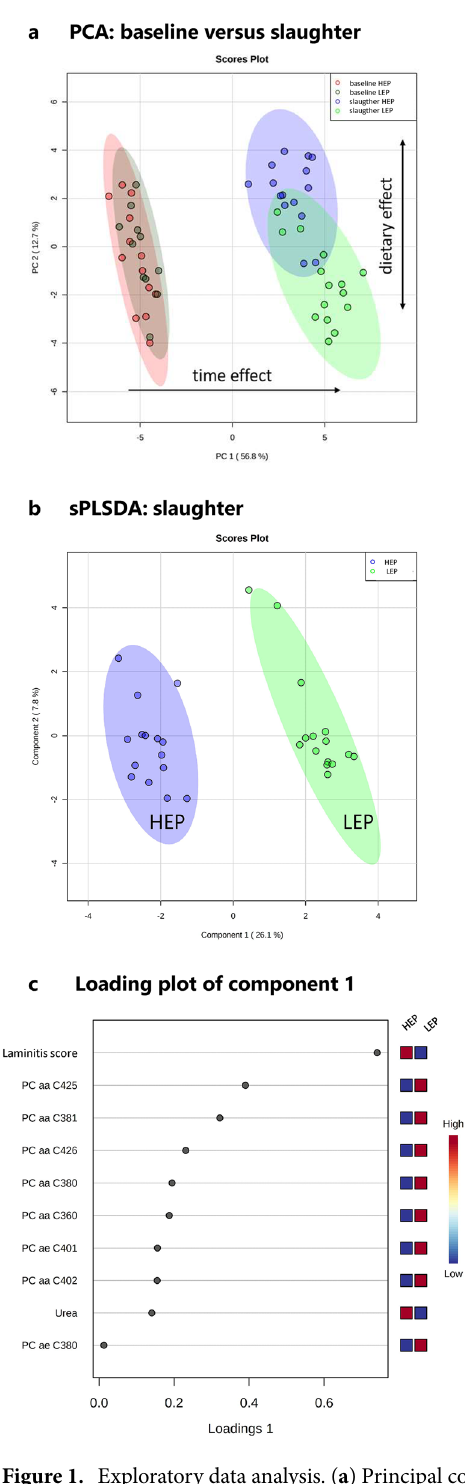
Figure 1. Exploratory data analysis. ( a ) Principal component analyses (PCA) of the combined data set of blood metabolome, body weight, insulin concentration, laminitis score, heel horn erosion and interdigital dermatitis score. Group fed low energy and protein diet (LEP): baseline n = 11, slaughter n = 15. Group fed high energy and protein diet (HEP): baseline n = 13, slaughter n = 15. Each dot represents the data of one bull at one sampling day. ( b ) Scores plot of sparse partial least squares-discriminant analysis (sPLS-DA) between components 1 and 2 applied to the dataset only at slaughter, n = 15 (blood metabolome, blood biochemistry, insulin concentration, body weight, laminitis score, heel horn erosion and interdigital dermatitis score). ( c ) Loadings of component 1 calculated by sPLS-DA of the dataset at slaughter. The variables listed on the left were ranked by the absolute values of their loadings, the color scheme on the right shows relative differences of the compounds between the feeding groups at slaughter. PC x:y = Phosphatidylcholine with total length of x carbon atoms and y unsaturated bonds in its acyl chains, aa = diacyl, ae =